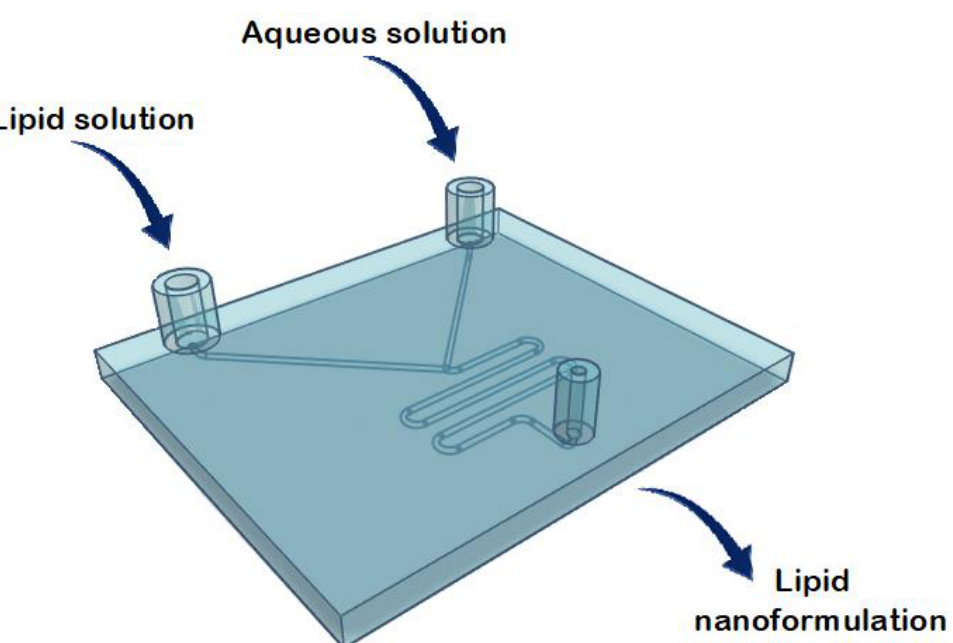
Figure 5. Representation of the structure of the commercial microfluidic chip for the lipid nanoformulations.